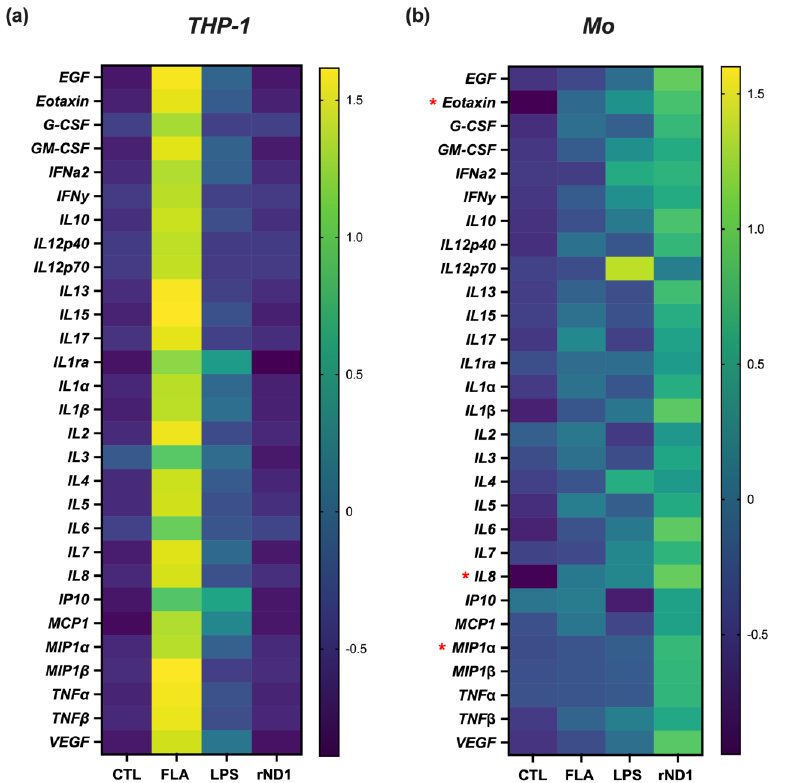
Figure 3. THP-1 cells and mononuclear cells (Mo) showed a differential cytokines profile after stim- ulation with rND1. The secreted pattern of cytokine in both ( a ) THP-1 and ( b ) Mo cells after 3 h of incubation with 1 µg/mL rND1 is shown in a heat map. Values of each cytokine were normalized to z-score. Each cytokine is presented as the mean of several independent experiments in THP1 (n = 3) and Mo (n = 4). FLA: Flagellin from S. typhimurium (50 ng/mL); LPS: Lipopolysaccharide from E. coli k12 strain (1 μ g/mL). Red Asterisks indicate significant differences between rND1, compared to the unstimulated control by One- way ANOVA and Tukey’s multiple comparison tests. Cytokine values in pg/mL are shown in Tables S1 and S2 of Supplementary Materials. * p < 0.05.